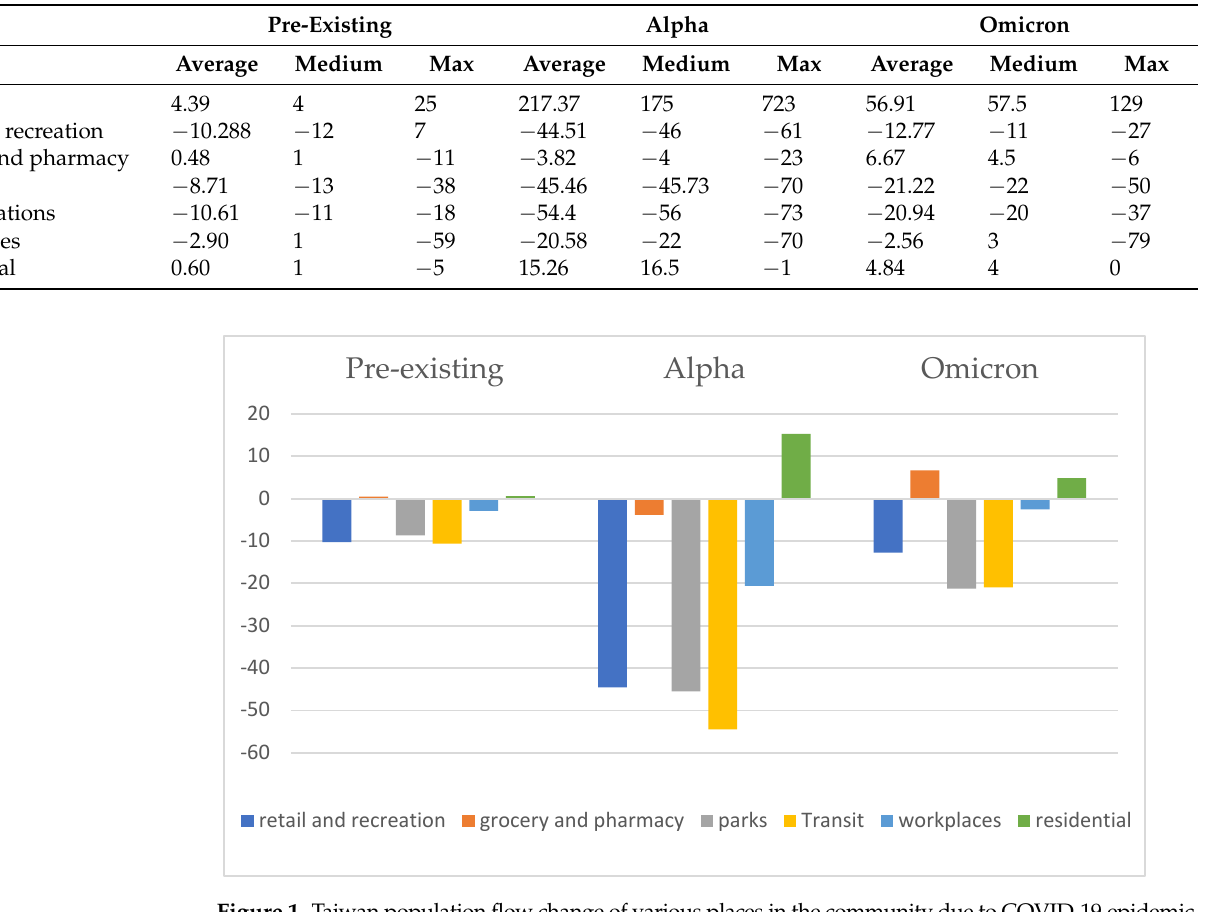
Table 1. The population flow change of each place in the Pre-existing epidemic, Alpha epidemic, and